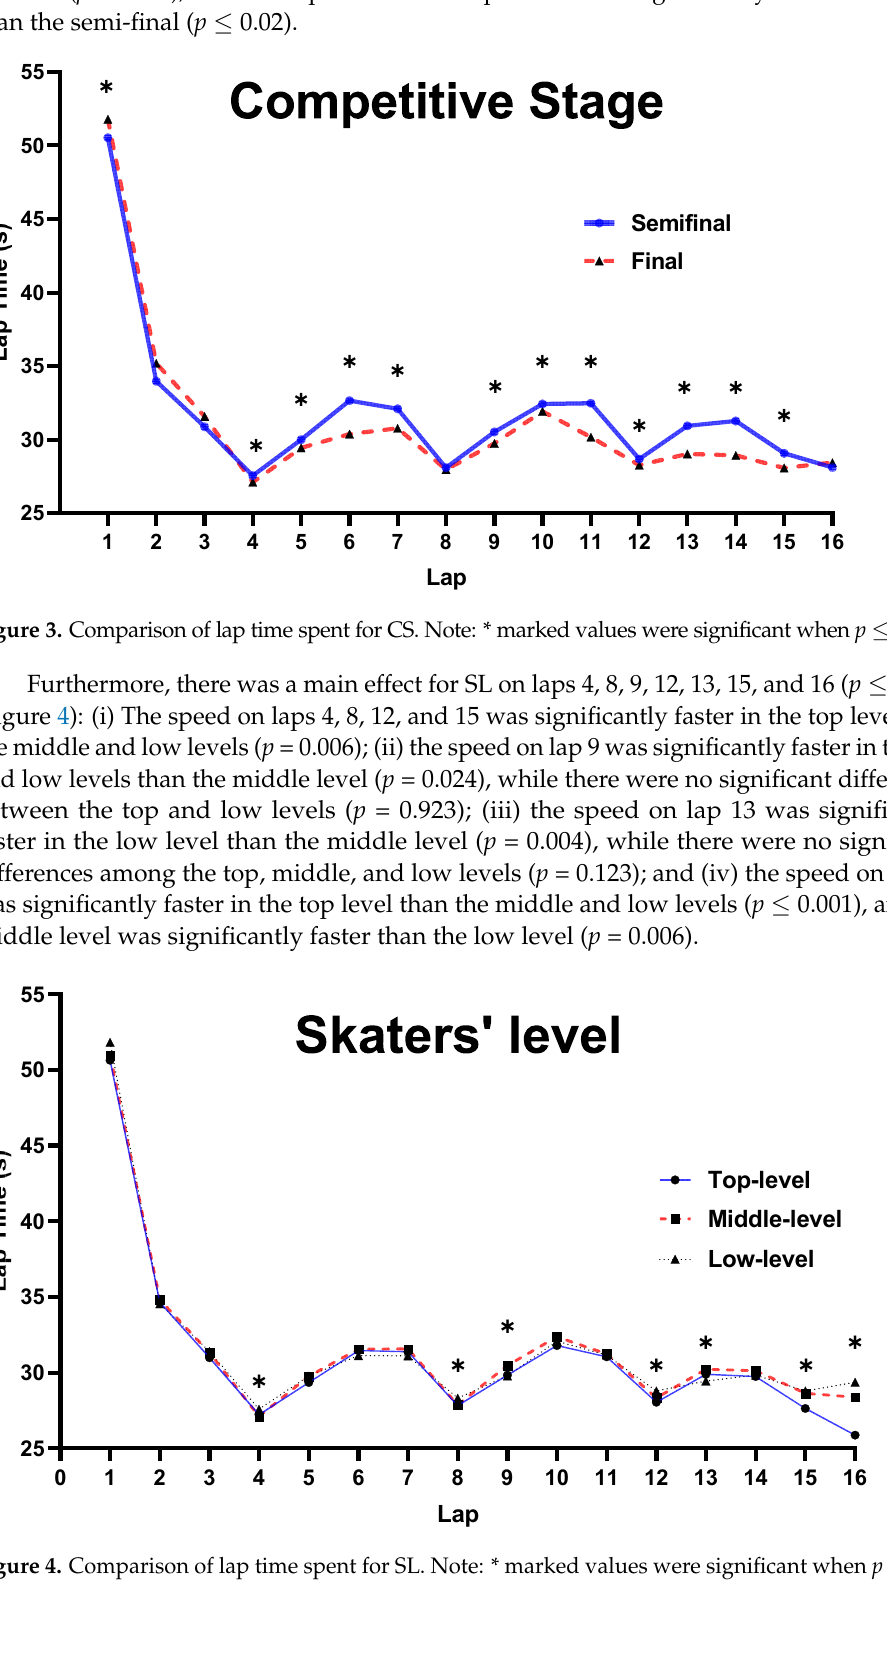
Additionally, there was a main effect for CS on laps 1, 4, 5, 6, 7, 9, 10, 11, 12, 13, 14, and 15 ( p ≤ 0.038) (Figure 3). The speed on lap 1 was significantly faster in the semi-final than the final ( p = 0.038), while the speed on other laps above was significantly faster in the final than the semi-final ( p ≤ 0.02).